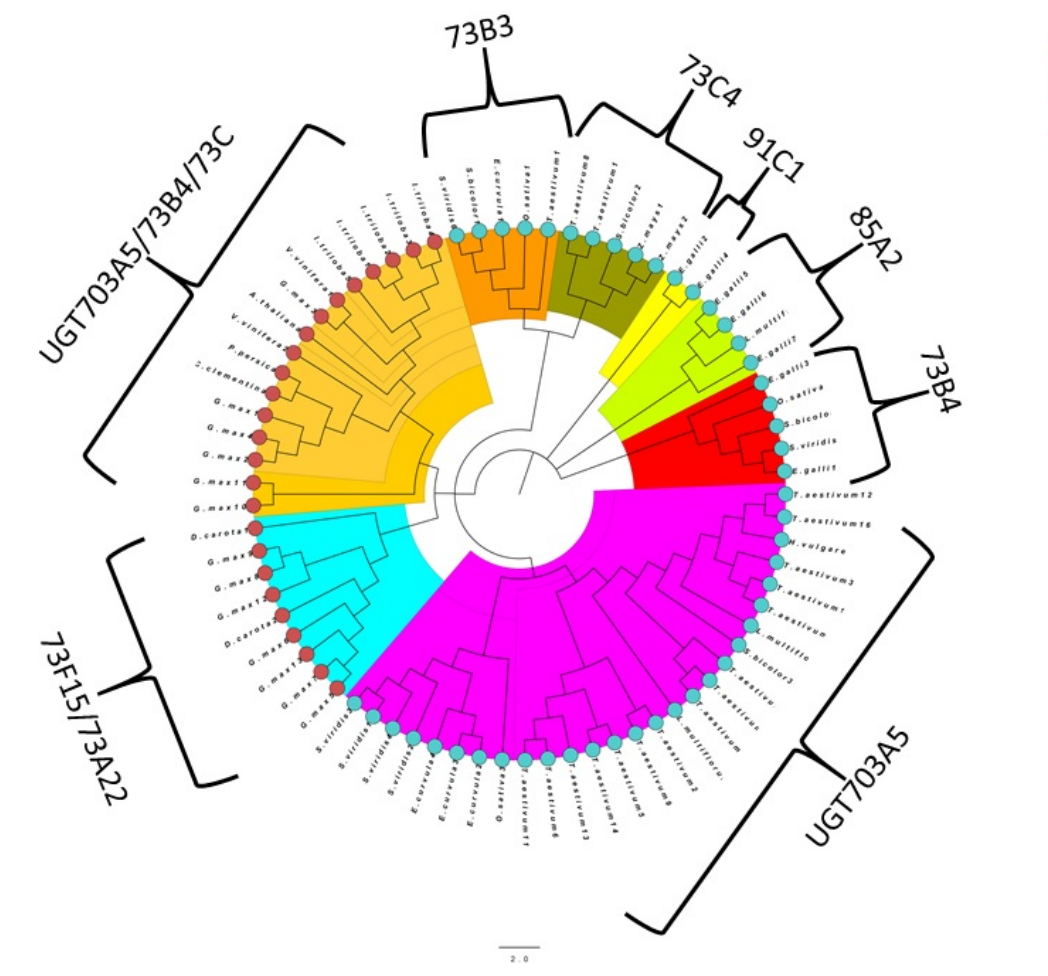
Figure 4. Phylogenetic tree of gene UDPGT . The tree was constructed using the maximum likelihood statistical technique with 1000 bootstrap repetitions. The circular nodes in red and blue represent dicot and monocot species. The scale bar for evolutionary distance is 2.0. Major clades are highlighted with colors: UGT703A5/73B4/73C (light orange), 73B3 (dark orange), 73C4 (green), 91C1 (yellow), 85A2 (light green), 73B4 (red), UGT703A5 (pink), and 73F15/73A22 (blue).